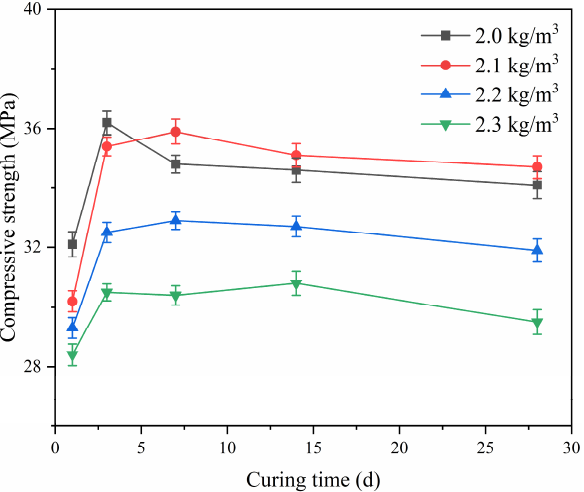
Figure 9. Compressive strength of high-temperature-resistant and high-density anti-corrosion cement slurry.